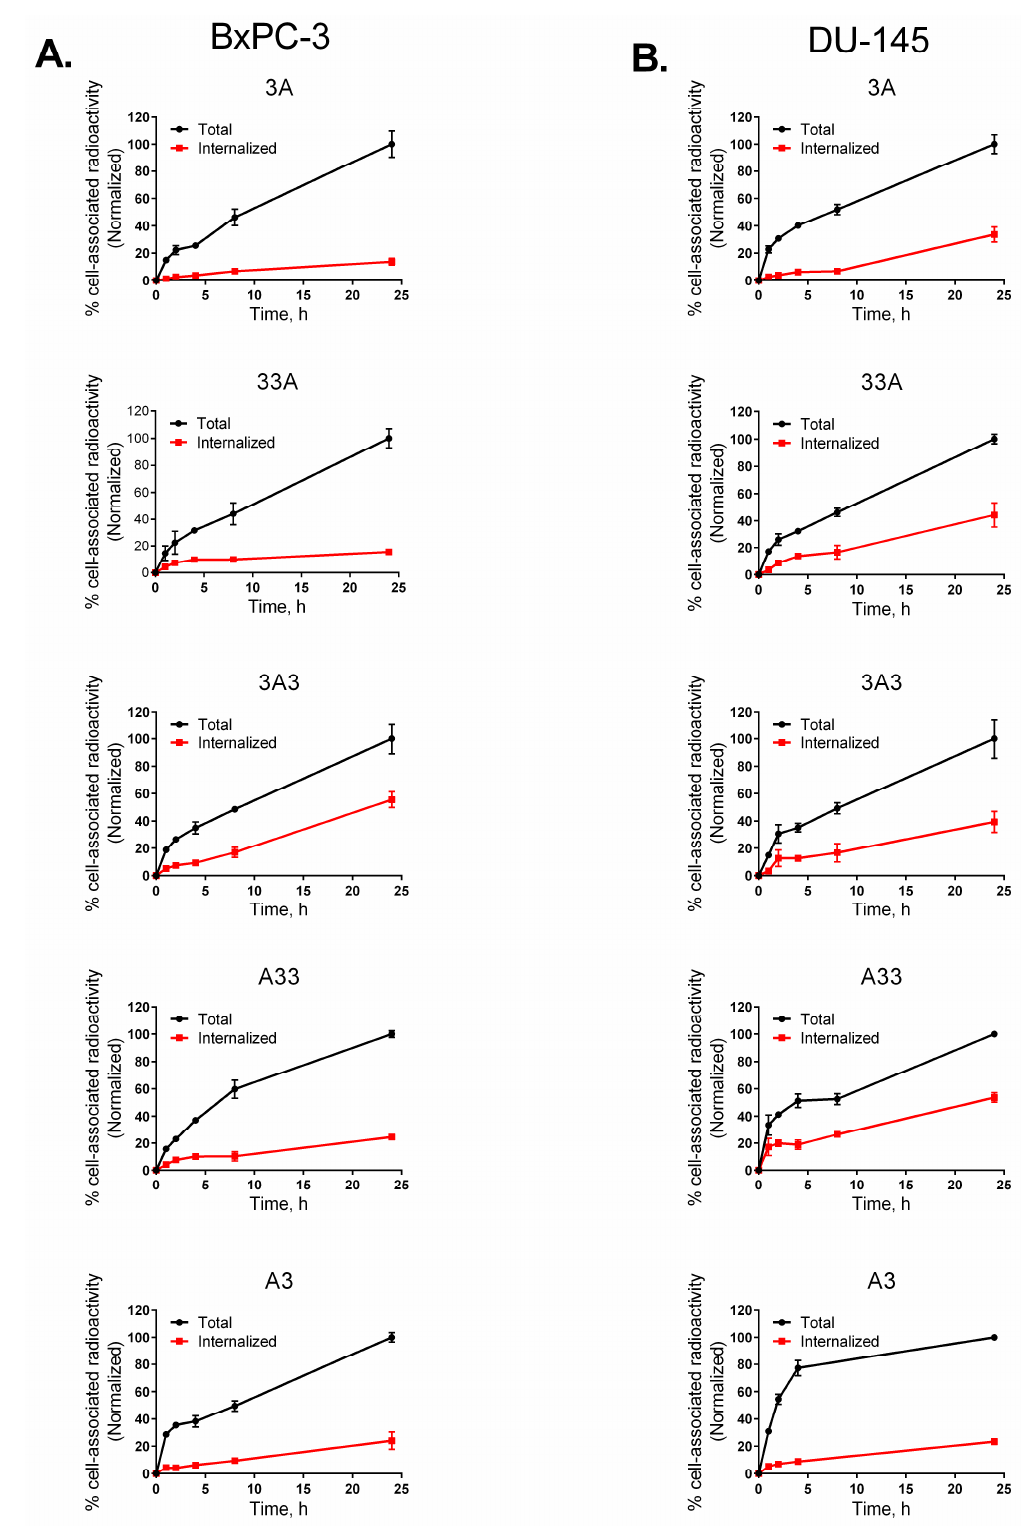
Figure 5. Cellular processing of different 111 In-labelled ABD-fused anti-HER3 affibody molecules by HER3-expressing BxPC-3 ( A ) and DU-145 ( B ) cell lines with up to 24 h of continuous incubation. Data were normalized to the maximum uptake in each cell line. Data is presented as an average ± SD ( n = 3).